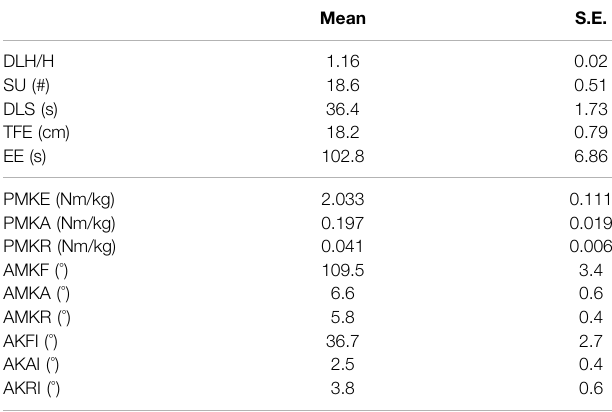
TABLE 2 | Core-related measurements and kinematic and kinetic measurements during the DJ landing